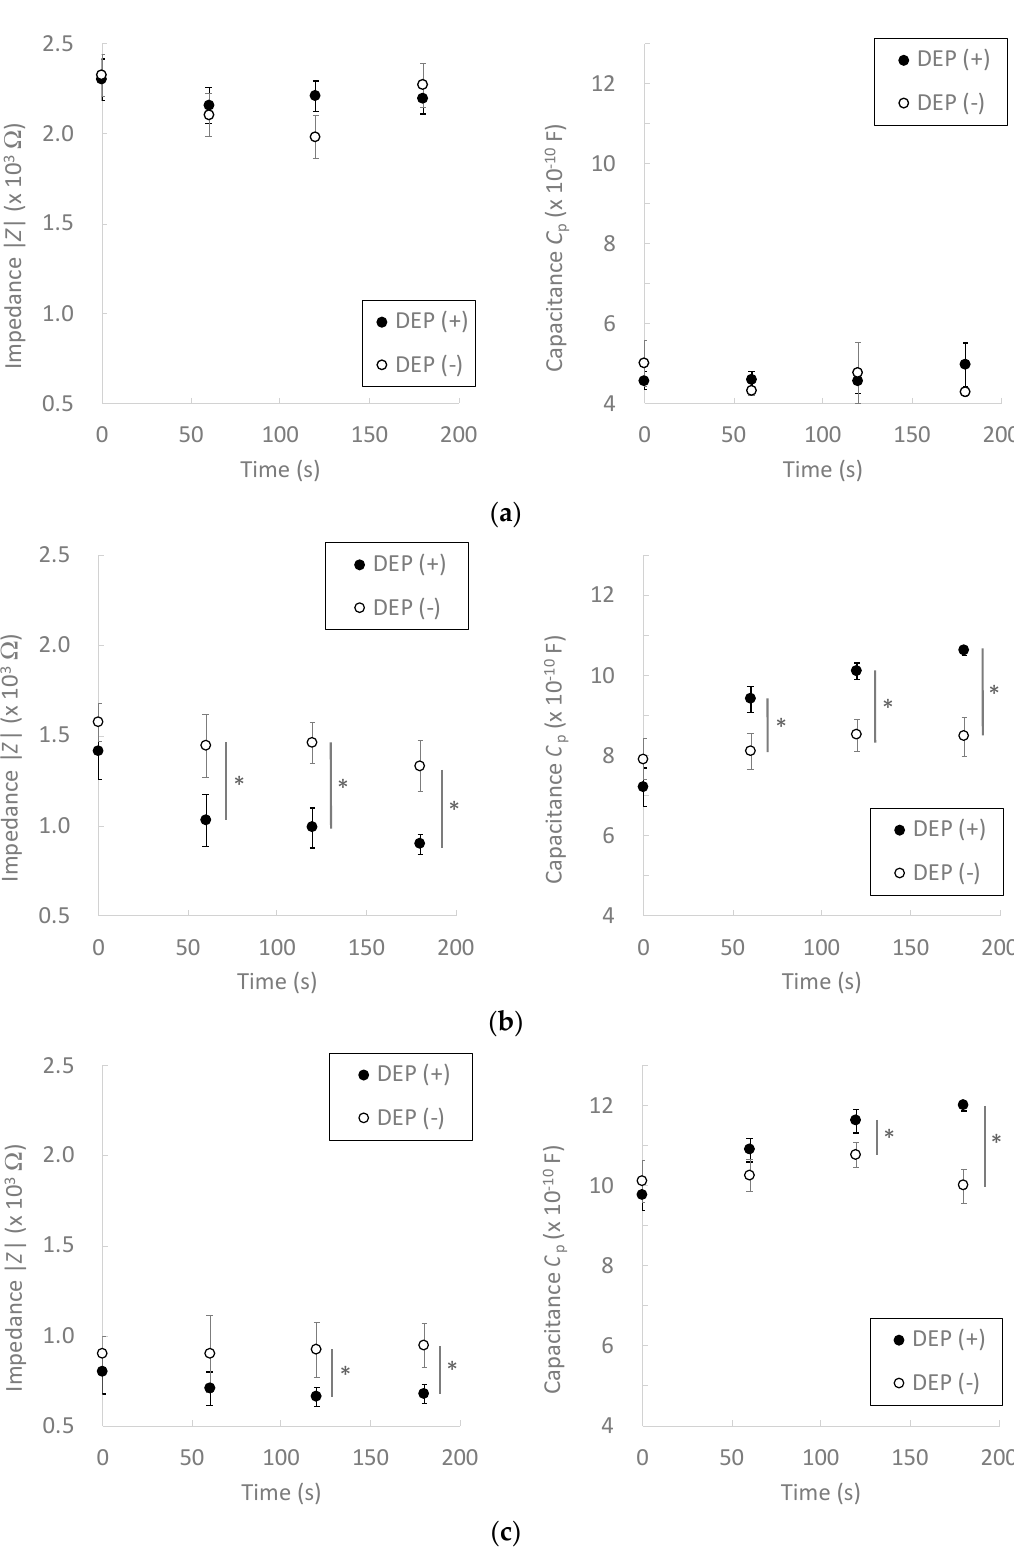
Figure 6. Effect of dielectrophoretic cell accumulation on the electrical impedance and capacitance of chondrocyte suspensions of ( a ) 0.1, ( b ) 1.0, and ( c ) 10 × 10 6 cells/mL. Mean +/ − SD, n = 7. * indicates a significant difference between DEP (+) and DEP (–) groups, p < 0.05.